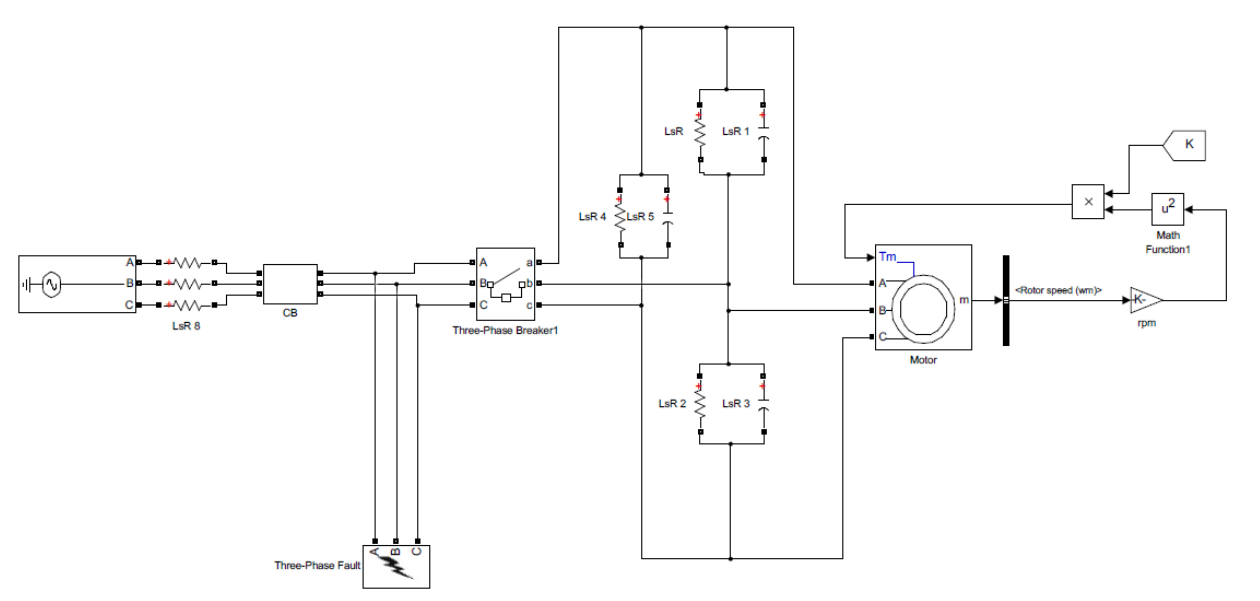
Figure 11. Simulation testbed for “Square D QOB-3100” circuit